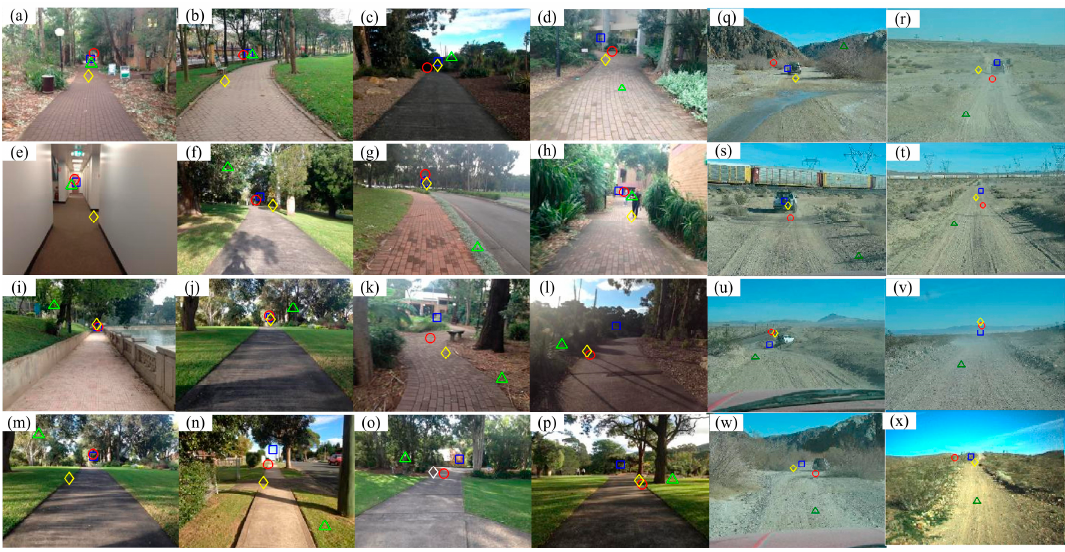
Figure 5. Examples of vanishing point estimation with different methods. Ground truth: blue square, proposed method: red circle, Gabor-based method [3]: yellow rhombus, Hough-based method [23]: green triangle (( a – p ) from PLVP dataset, ( q – x ) from Challenge dataset). Table 1. Vanishing point estimation performance.